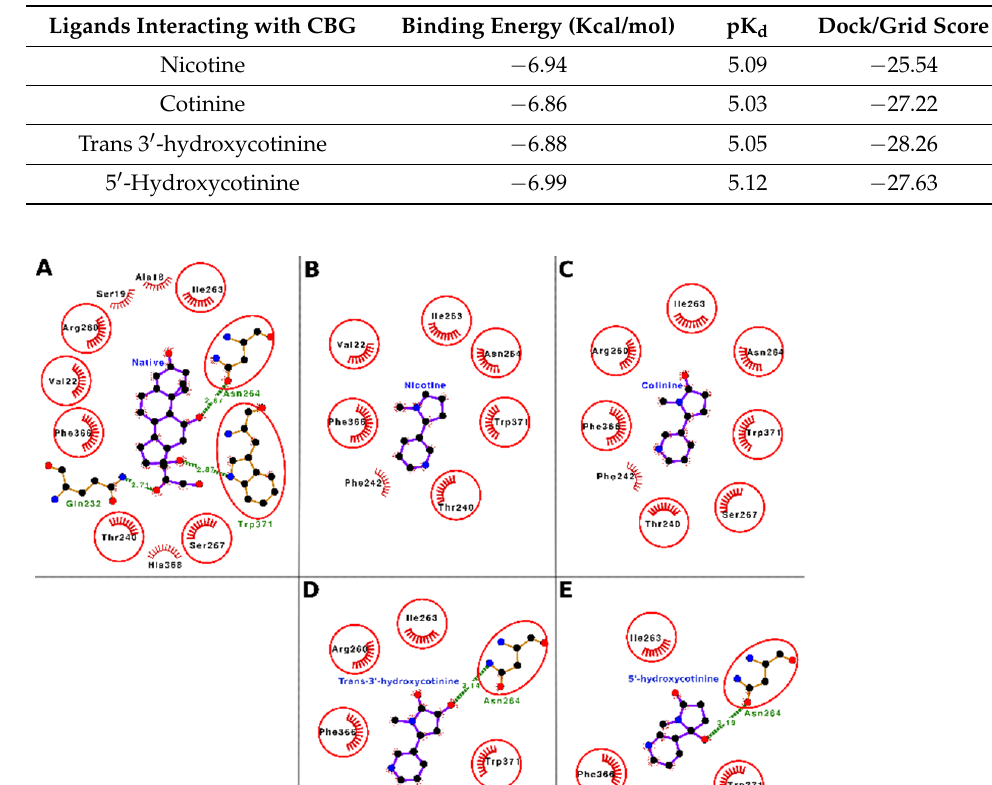
in three nonbonded contacts. When the binding of nicotine was compared with that of